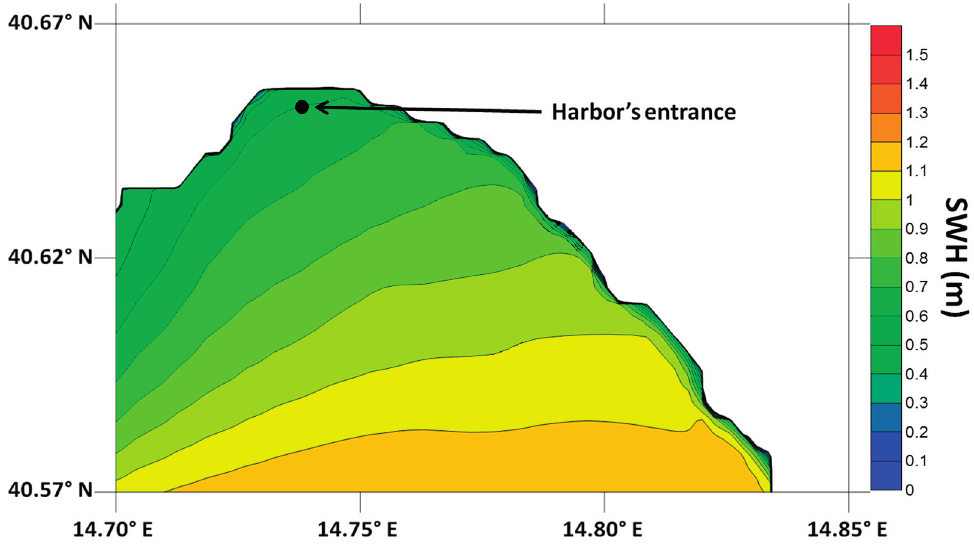
Figure 11. Significant Wave Height field in the Salerno bay as computed by the SWAN model. Boundary conditions to the SWAN grid were those given by the ECWMF grid points closer to Salerno at 12:00 a.m. (UTC) i.e. , SWH 1.4 m, source direction 244°, wind speed at 10 m: 6.17 m/s, wind source direction: